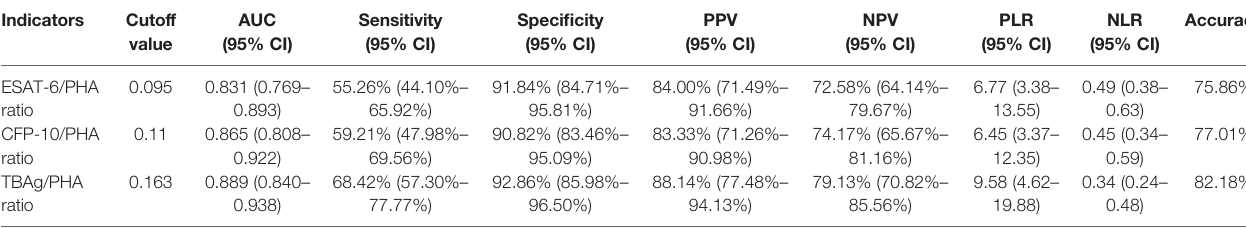
TABLE 3 | The performance of TBAg/PHA ratio for distinguishing between TBM and BM.